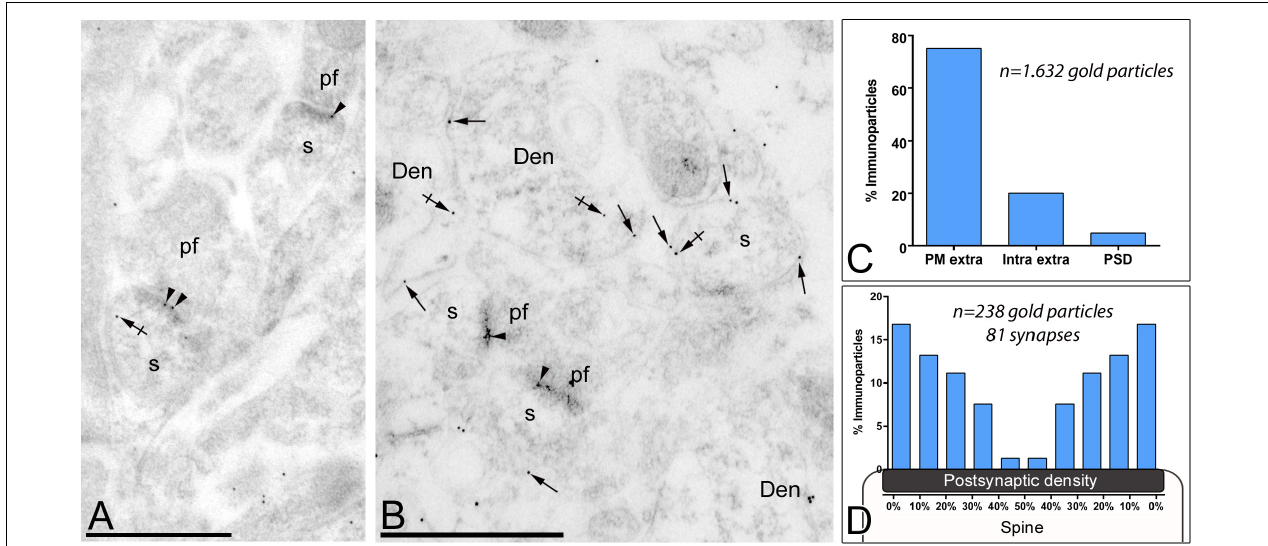
FIGURE 5 | Subsynaptic localization of G α o in PCs. Electron micrographs of the molecular layer of the cerebellum showing G α o immunoparticles in excitatory synapses of PCs using a post-embedding immunogold method. (A,B) Immunoparticles for G α o were observed in the PSD of PC spines (s) (arrowheads) establishing excitatory synapses with parallel fiber terminals (pf). They were also observed along the extrasynaptic plasma membrane (arrows) of PC spines (s) and PC dendrites (Den), and at intracellular sites (crossed arrows). (C) Histogram showing the percentage of immunoparticles for G α o in different compartments of PC spines. A total of 1,632 G α o immunoparticles were analyzed in PC spines, of which 5% were located in PSDs, 75% along the extrasynaptic plasma membrane and 20% at cytoplasmic sites. (D) Quantitative analysis showing the tangential distribution of immunoparticles for G α o across the PSD. G α o immunoparticles were preferentially located at the edges of the PSD, with the density decreasing toward the middle of the synapse. Scale bars: (A,B) 500 nm.